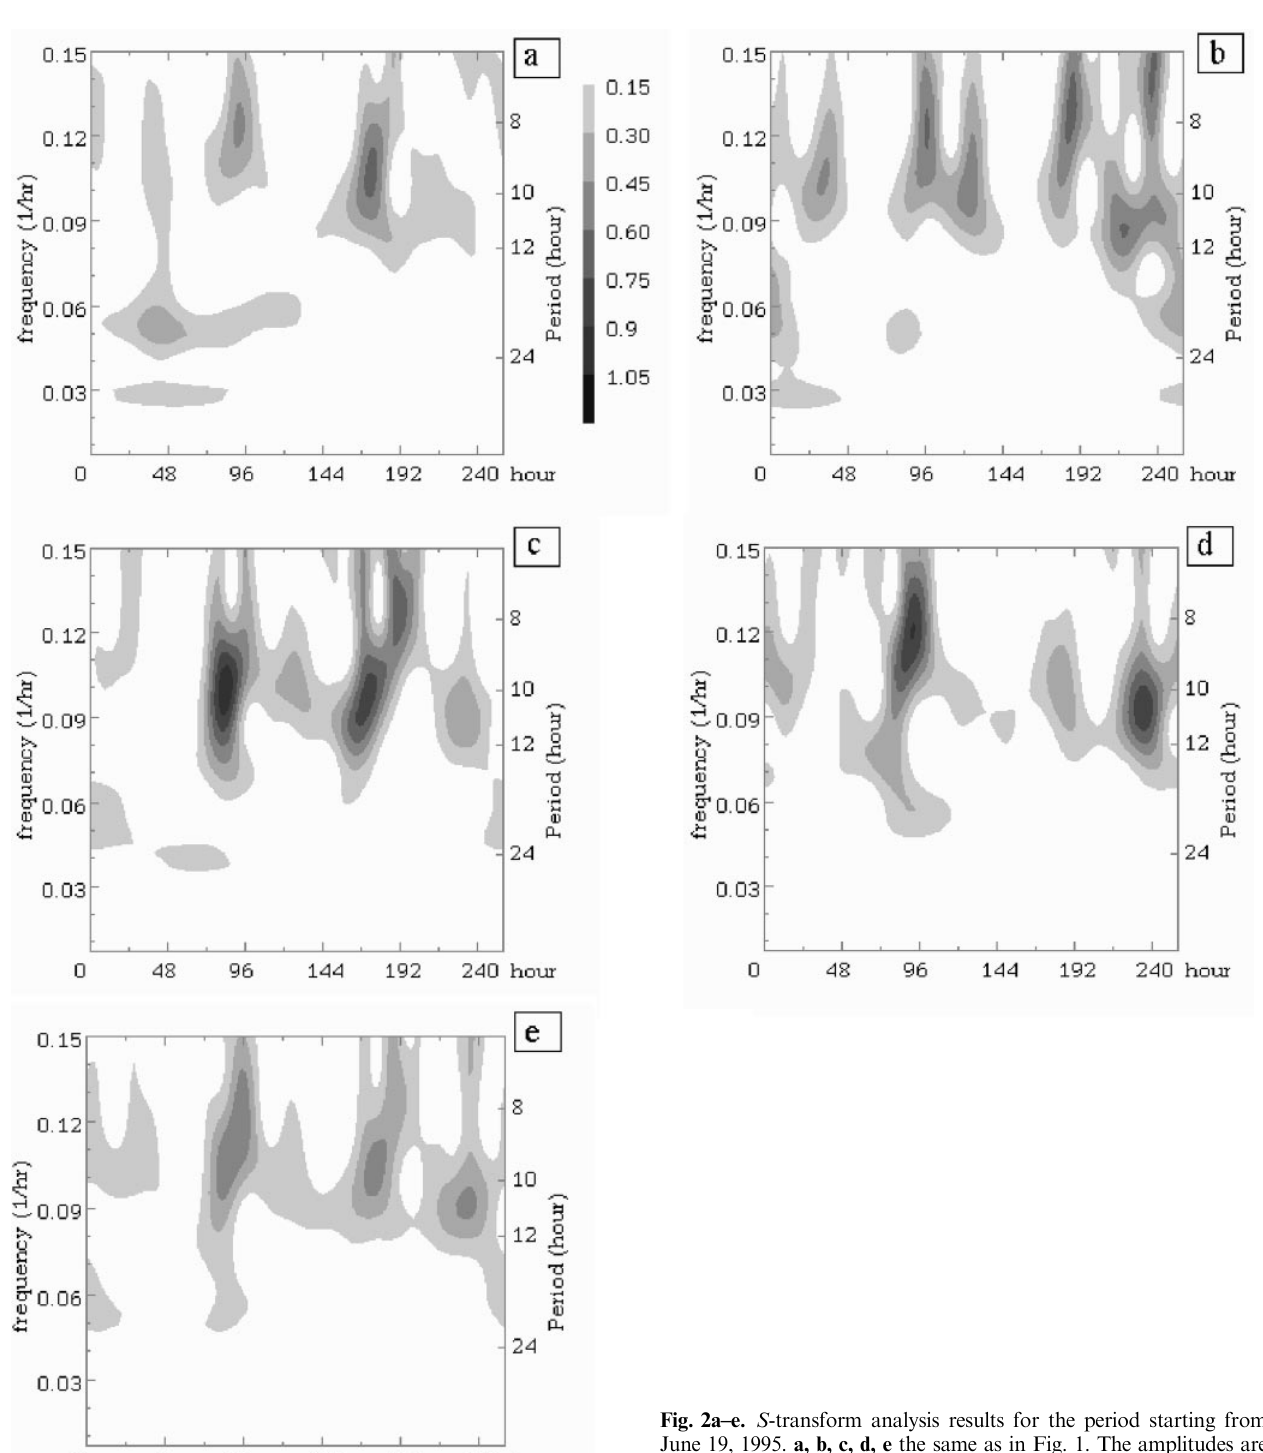
Fig. 2a–e. S -transform analysis results for the period starting from June 19, 1995. a, b, c, d, e the same as in Fig. 1. The amplitudes are indicated by shades of